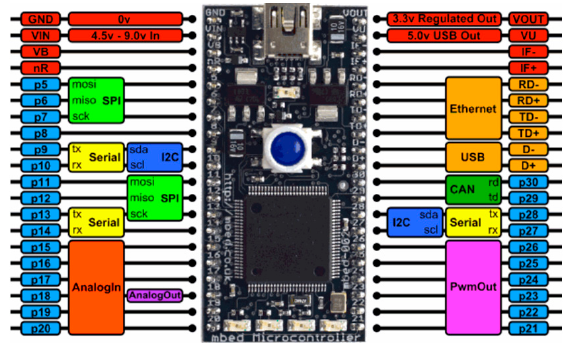
Figure 2. The microcontroller mbed NXP LPC1768.